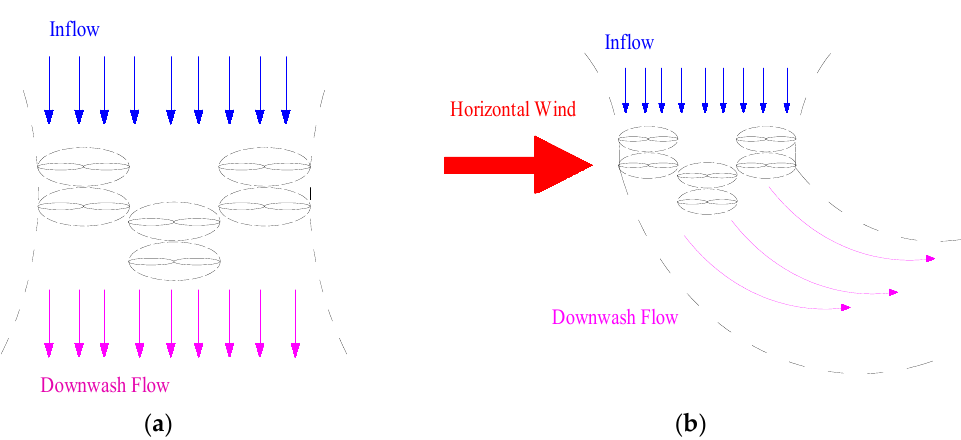
Figure 2. Flow model of coaxial Tri-rotor MAV in the horizontal wind: ( a ) No wind; ( b ) Horizontal wind.